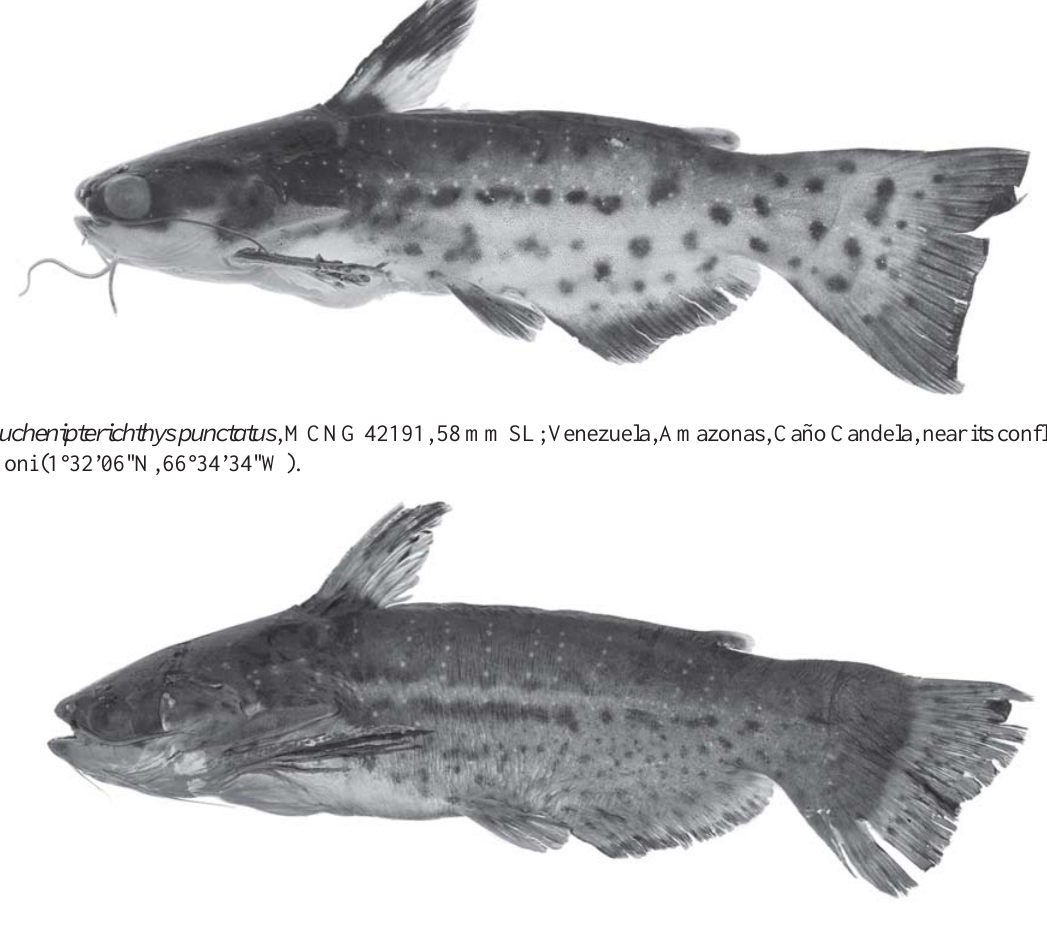
Fig. 9. Auchenipterichthys punctatus , MCNG 25981, 149 mm SL; Venezuela, Amazonas, río Siapa approximately 124 km from mouth in río Casiquiare (1°49’N, 65°48’W).